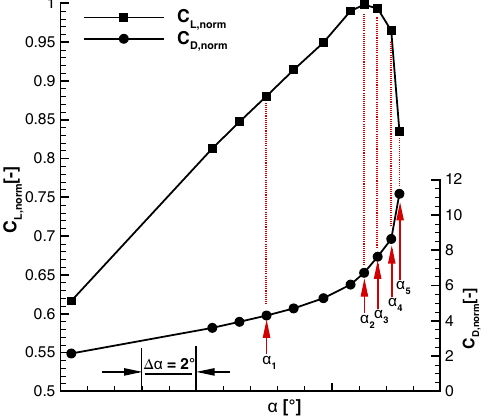
Figure 7. Lift and drag coefficients vs. angle of attack.